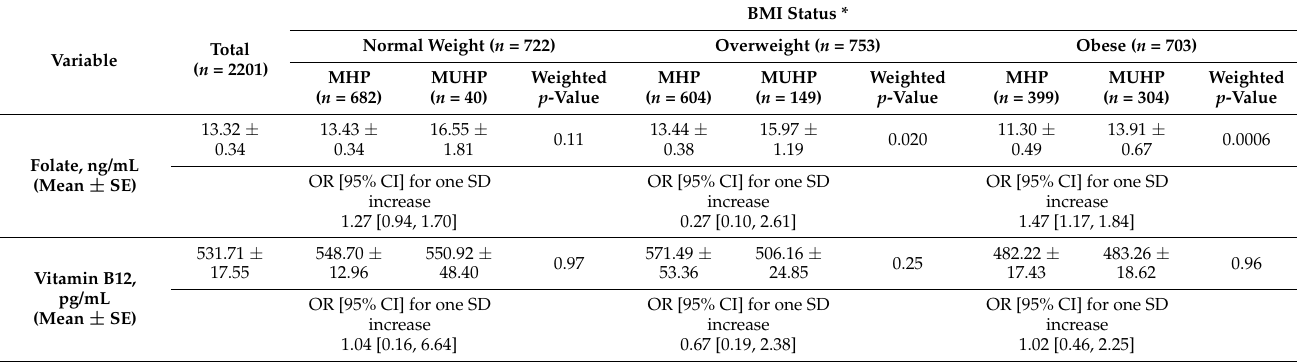
Table 6. Associations between plasma folate and vitamin B12 and metabolic phenotypes, based on BMI